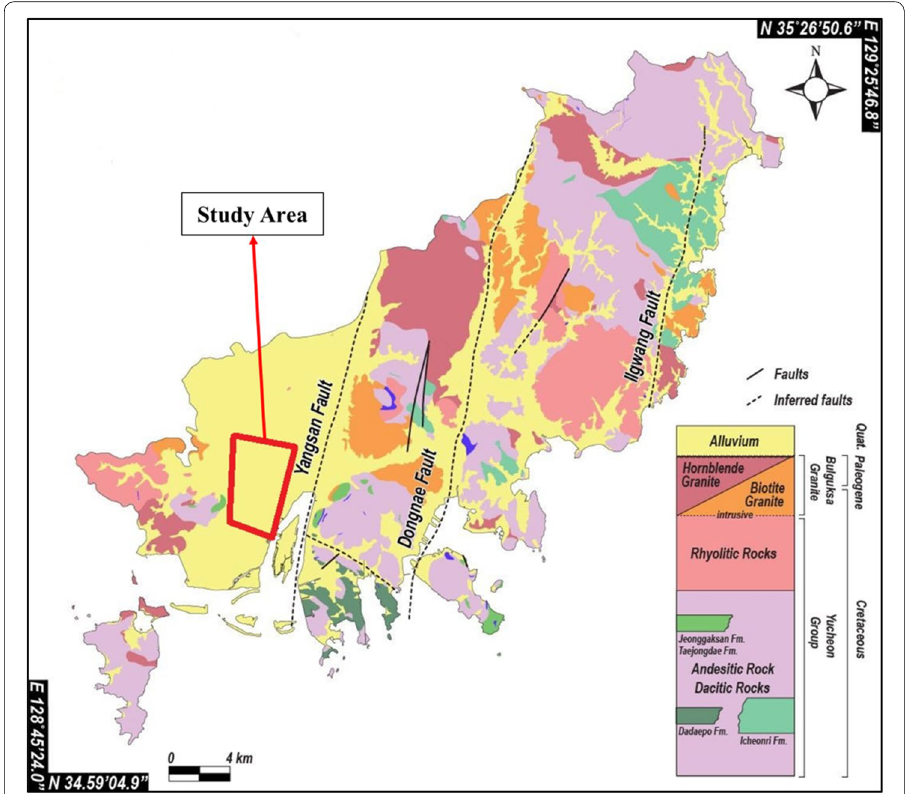
Fig. 3 Geological map of the Busan showing the distribution of basin‑fills and major faults